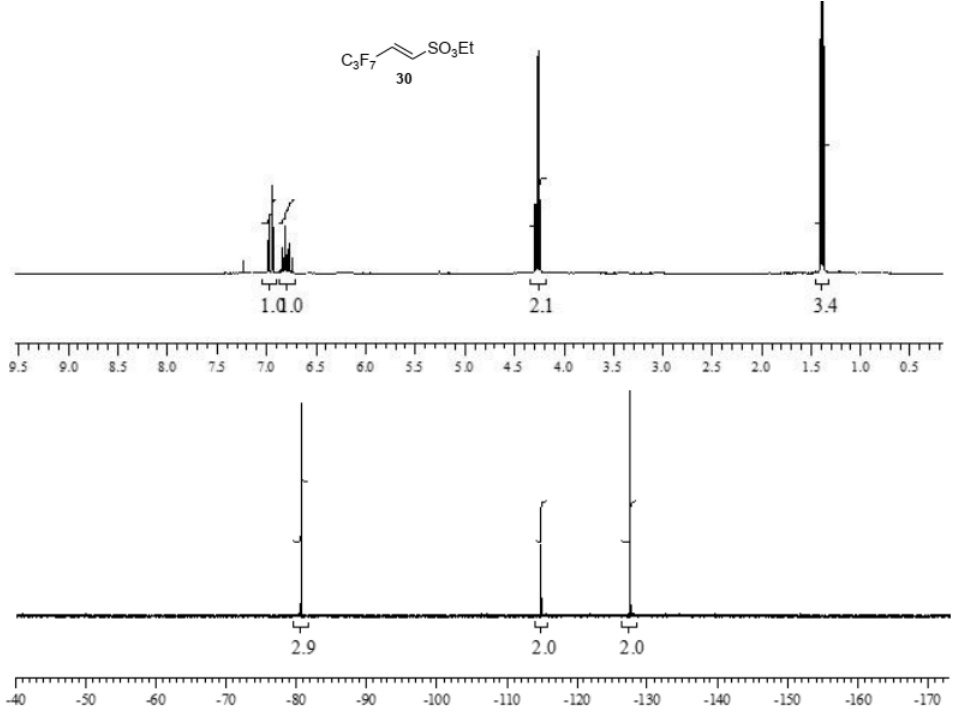
Figure 4. 1 H- and 19 F-NMR spectra images of (E)-ethyl 3,3,4,4,5,5,5-heptafluoropent-1-ene-1- sulfonate 30 .